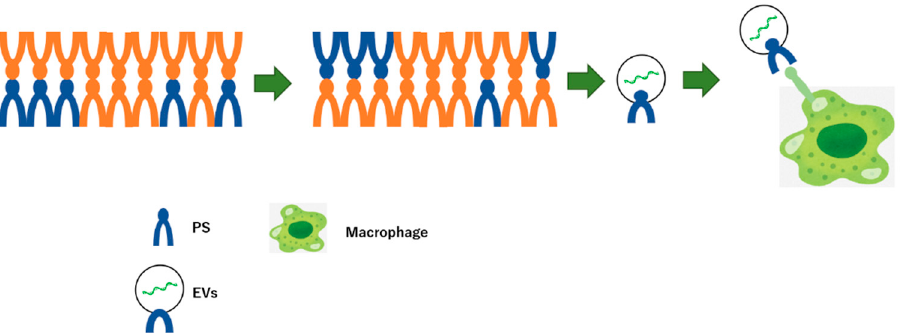
Figure 3 . Macrophage phagocytoses apoptotic cells via externalization of phosphatidylserine (PS) on EVs induced apoptosis as “eat me signal”. In apoptotic conditions, PS in the plasma membranes of cells externalizes, which is recognize by macrophages. Further, like the plasma membrane, the surface of the EVs has the PS, leading to uptake into